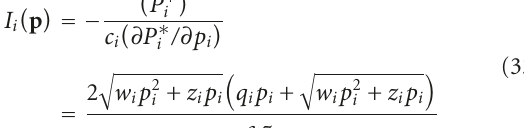
Figure 8: Power versus the location of the second